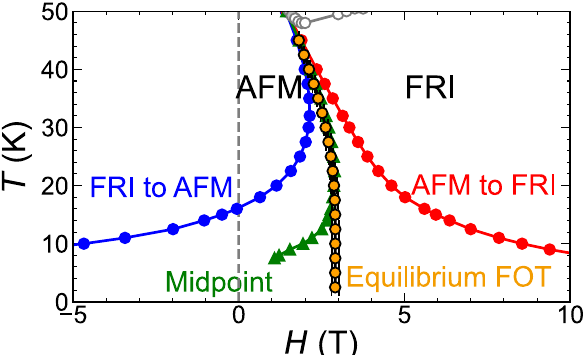
Figure 6. Determination of the equilibrium first-order transition line. Determined phase boundary indicated by orange circles with error bars, which are superimposed on the low-temperature enlarged view of Fig. 1g.